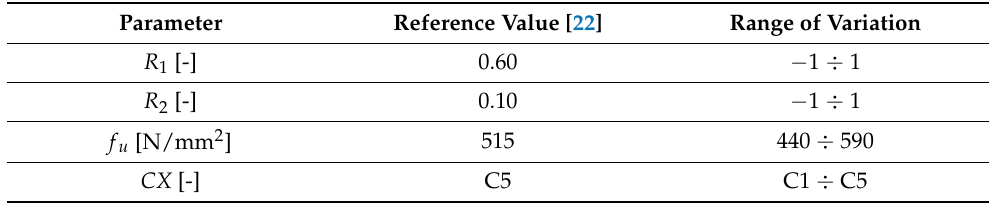
Table 4. Assumed ranges of variation for R 1 , R 2 , f u , and C X for parametrical analyses.